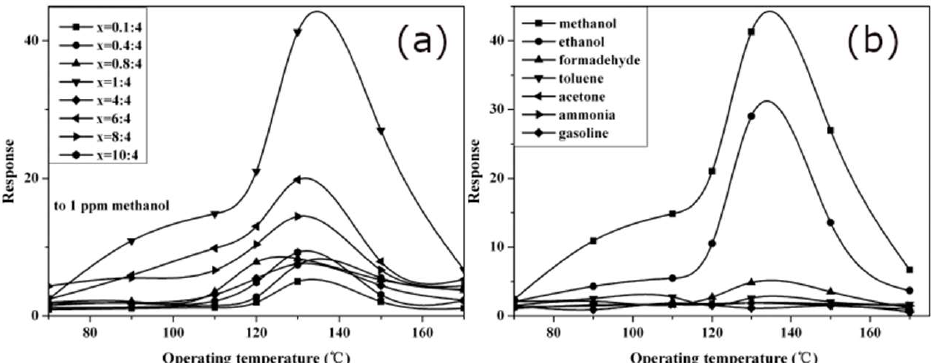
Figure 16. Methanol sensor developed by Zhu et al.: ( a ) effect of varying template-monomer ratio on response to 1 ppm methanol, ( b ) selectivity of 1:4 methanol-monomer sensor, showing response to 1 ppm of various gases. The functional monomer was methacrylic acid, and Ag-LaFeO 3 was used as crosslinker (1:4:10 template-monomer-crosslinker). The resulting MIP was ground and printed onto an alumina electrode, and the response was recorded as the ratio of electrical resistance in the gas to that in air. Reproduced with permission [50].